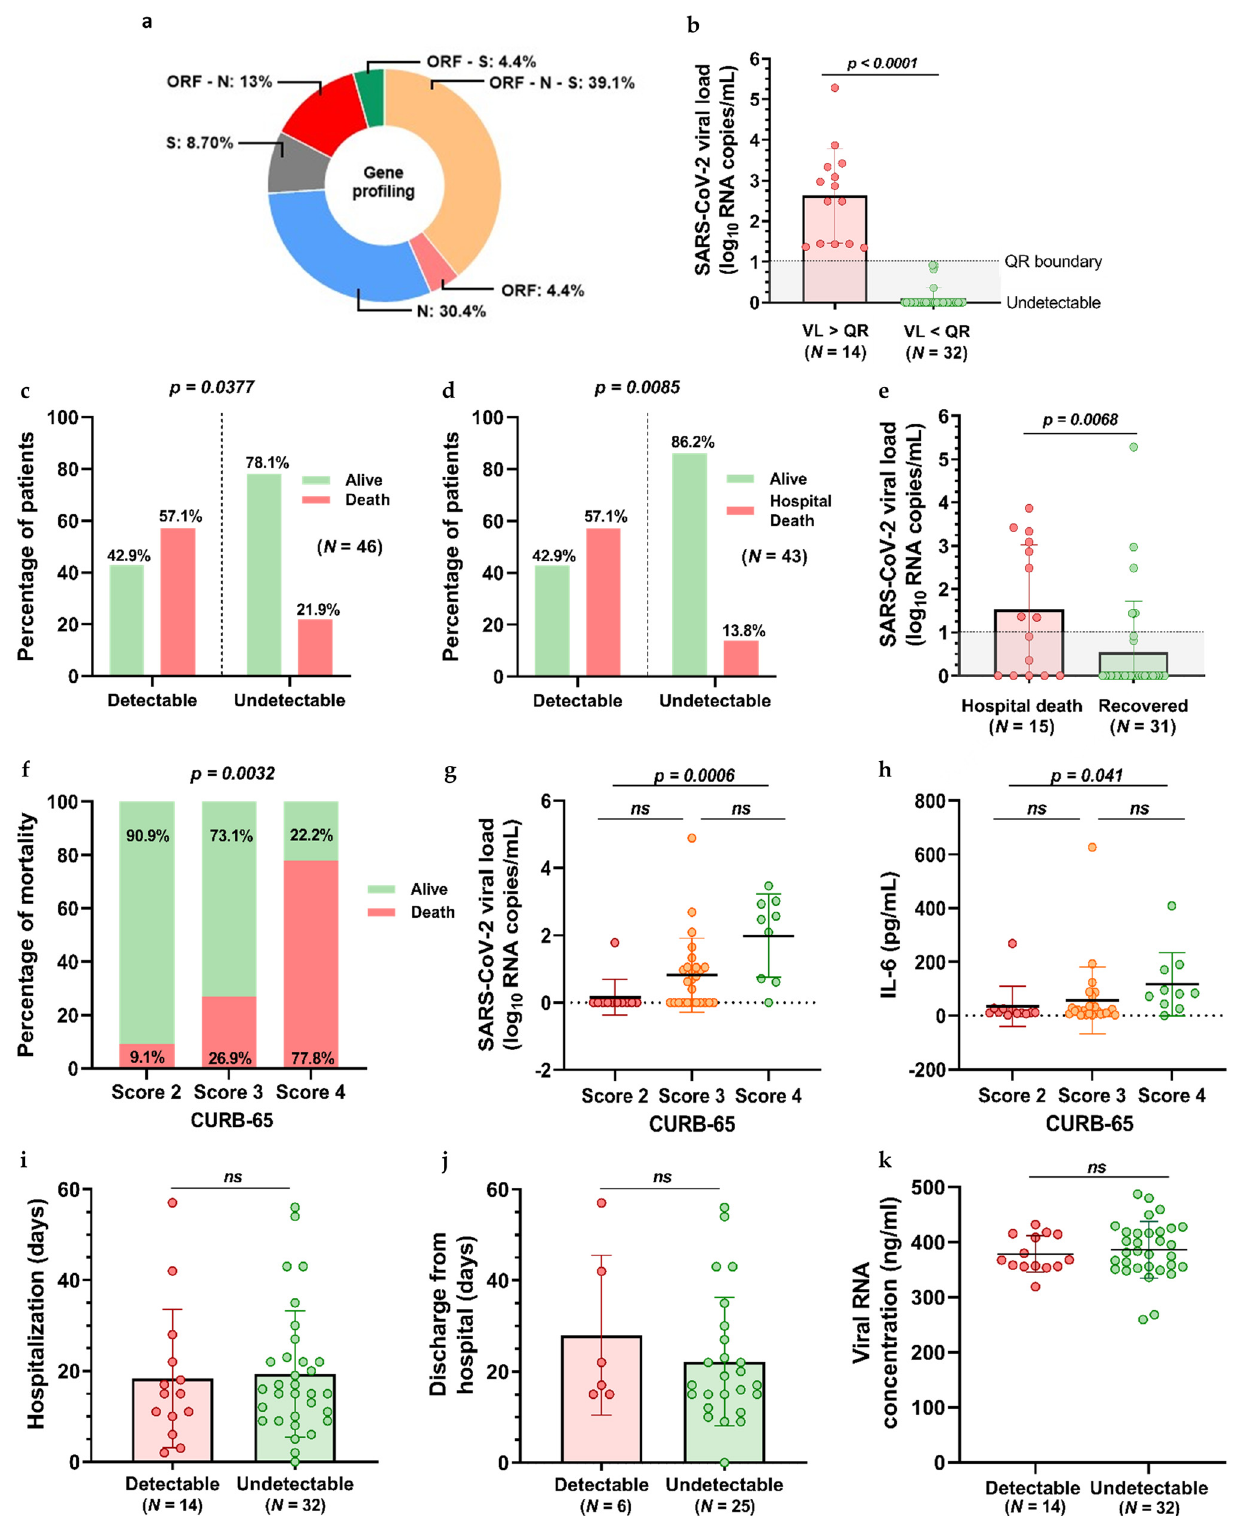
Figure 1. Gene profiling and SARS-CoV-2 RNA detection in serum at baseline before LDRT is administered. ( a ) Distribution of N, S, and ORF1ab gene amplification by qRT-PCR was detected in 23 patients, from which 14 were subsequently considered positive for SARS-CoV-2 following the guidelines of our laboratory. ( b ) SARS-CoV-2 viral load (VL) distribution; 4 patients presented viral loads below the range of detection and were considered undetectable throughout the trial. p values are from a two-tailed Wilcoxon rank sum test. ( c , d ) Percent of participants with detectable and